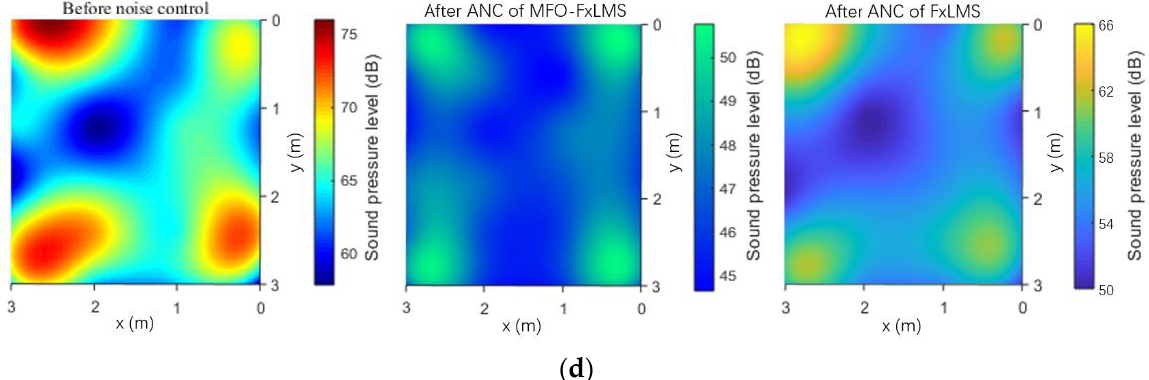
Figure 5. Contrast simulation results of MFO ‐ FxLMS and FxLMS algorithms: ( a ) 4 ‐ channel comparison; ( b ) 8 ‐ channel comparison; ( c ) 16 ‐ channel comparison; ( d ) 24 ‐ channel comparison.